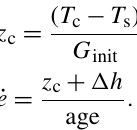
pography over a circle with a radius of π × z c , where z c is an estimated closure depth for the relevant thermochronometric system. The local relief correction (cid:49)h is then calculated for each sample